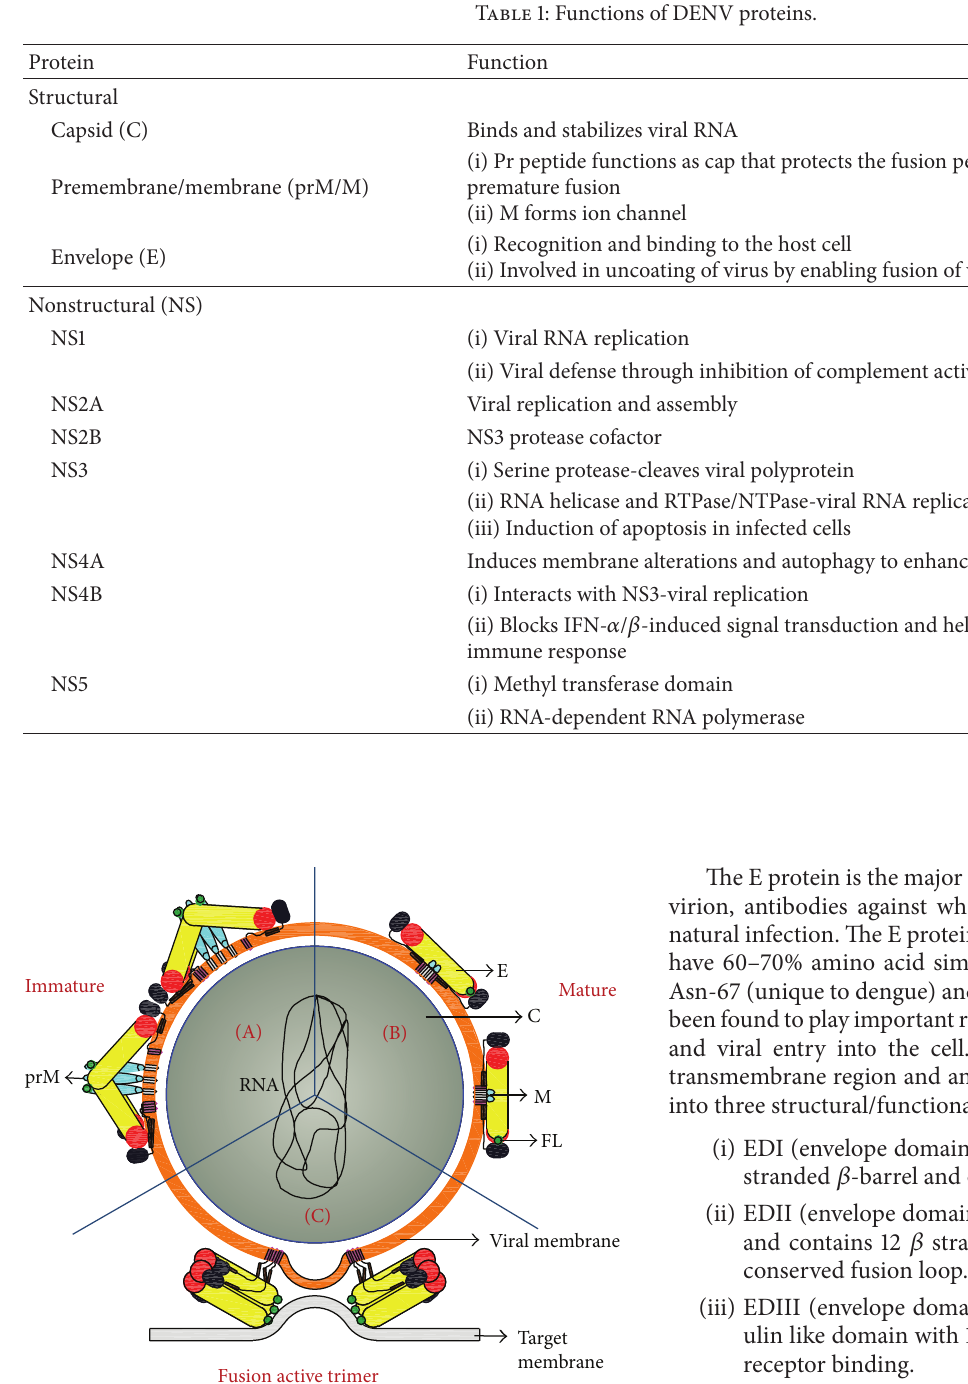
Table 1: Functions of DENV proteins.